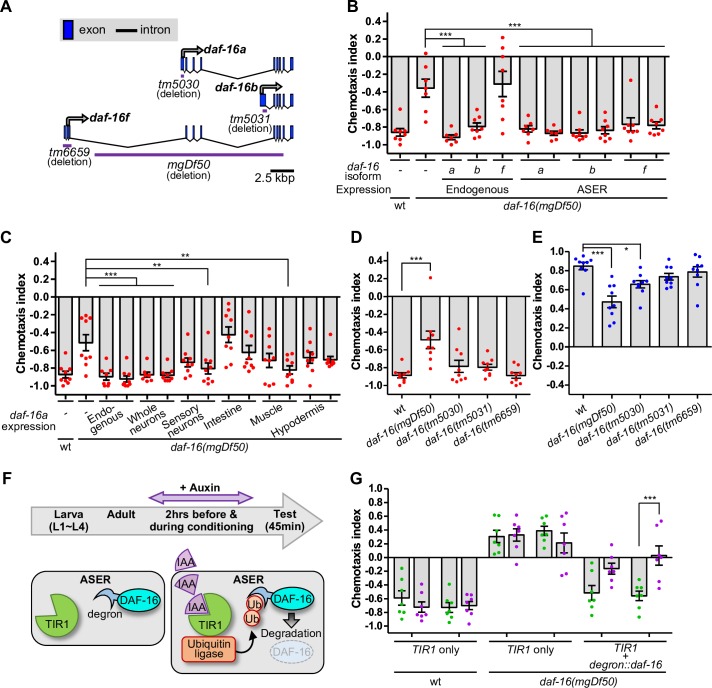
DAF-16 isoforms act in ASER during taste avoidance learning.(A) The genomic structures of DAF-16 isoforms and mutation sites of deletion mutants are shown. (B, C) Salt chemotaxis after high-salt conditioning in the absence of food. Each dot in red represents a chemotaxis index obtained from each trial. Each daf-16 isoform cDNA was expressed in daf-16(mgDf50) mutant animals by its own promoter or the ASER-specific gcy-5 promoter (B; N = 7 or 8). DAF-16a isoform was expressed by the H20, odr-4, ges-1, myo-3, and dpy-7 promoter, which drove expression in most or all neurons, amphid and phasmid sensory neurons except ASE and AFD, intestine, muscle, and hypodermis, respectively (C; N = 8 or 9). (D, E) Salt chemotaxis of daf-16 mutants carrying deletions in isoform-specific exon after high- (D) or low-salt (E) conditioning without food (N = 9). (A, B, D, E) Error bars indicate SEM. Dunnett’s test following one-way ANOVA, *p < 0.05, **p < 0.01, and ***p < 0.001. (F) Schematic of auxin-dependent expression of DAF-16 in ASER using degron-tagged DAF-16 and auxin interactive protein (TIR1). Auxin (IAA) induces ubiquitin (Ub)-dependent degradation of degron-tagged DAF-16. Animals are grown to the adult without auxin and then auxin was added for two hours before conditioning and during conditioning. (G) Salt chemotaxis of animals carrying transgenes after high-salt conditioning in the absence of food (N = 7). A green or purple dot represents a chemotaxis index obtained from each trial when treated with either the solvent, 0.25% ethanol or 1 mM auxin, respectively. Two lines of transgenic animals were tested. Error bars indicate SEM. Bonferroni multiple test following two-way ANOVA, ***p < 0.001.